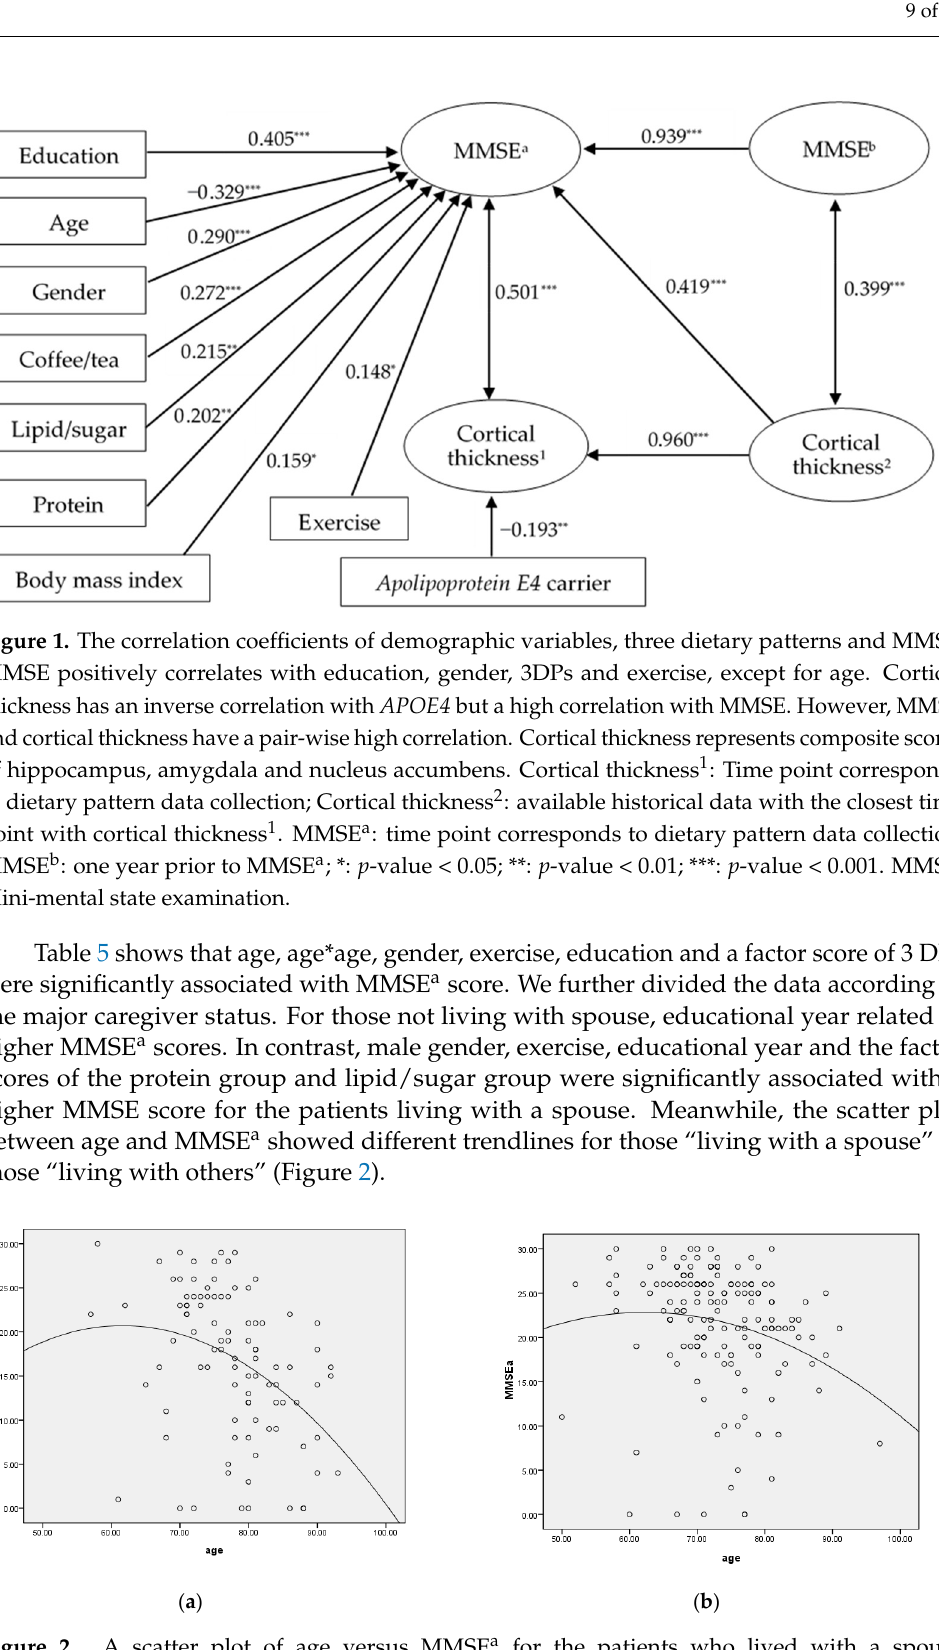
Figure 2. A scatter plot of age versus MMSE a for the patients who lived with a spouse ( p- value = 0.022) or not ( p -value < 0.001). Slower decline in MMSE a was found in those living with a spouse. MMSE, Mini-Mental State Examination. ( a ) The patients who did not live with a spouse; ( b ) the patients who lived with a